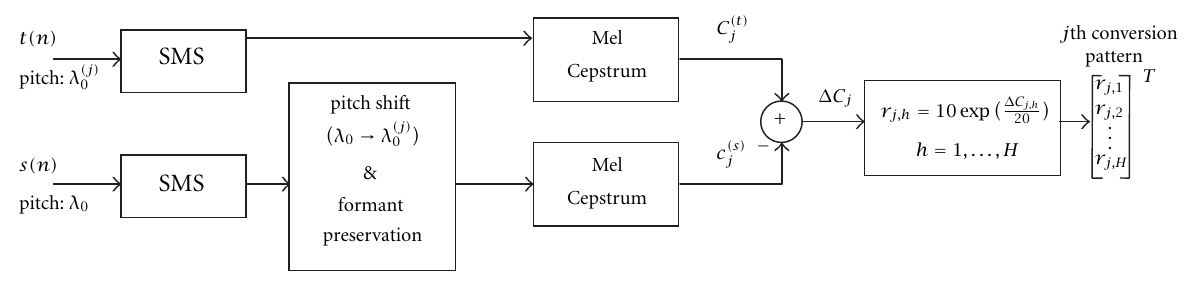
Figure 3: Schematic diagram of the computation of a conversion pattern to perform pitch shift with spectral correction.